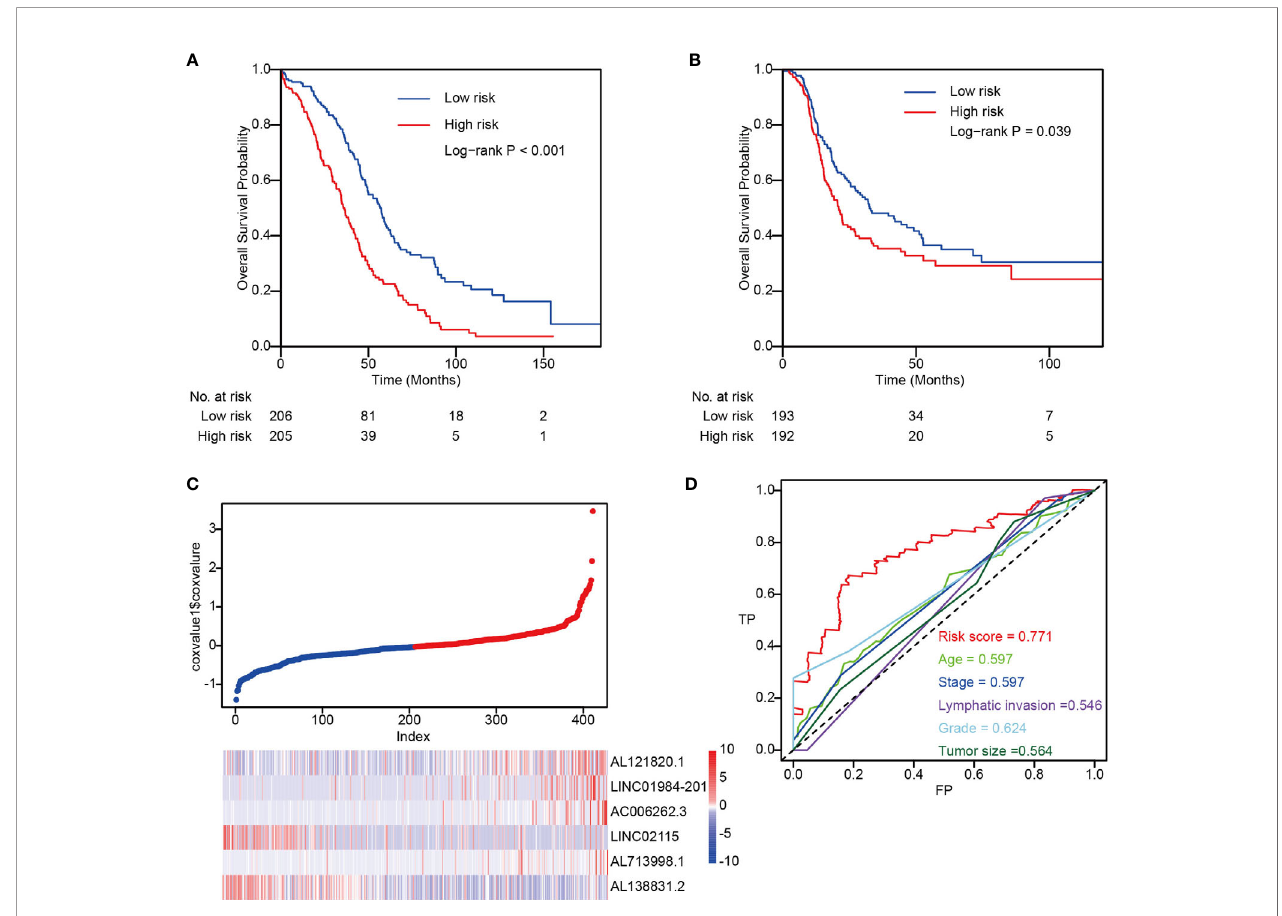
FIGURE 1 | The performance of risk score in TCGA dataset. (A) The overall survival difference between low-risk and high-risk groups; (B) The progression-free survival difference between low-risk and high-risk groups; (C) Detailed survival information and gene expression patterns in TCGA dataset; (D) Three years survival ROC by using risk score, age, stage, lymphatic invasion, grade, and tumor